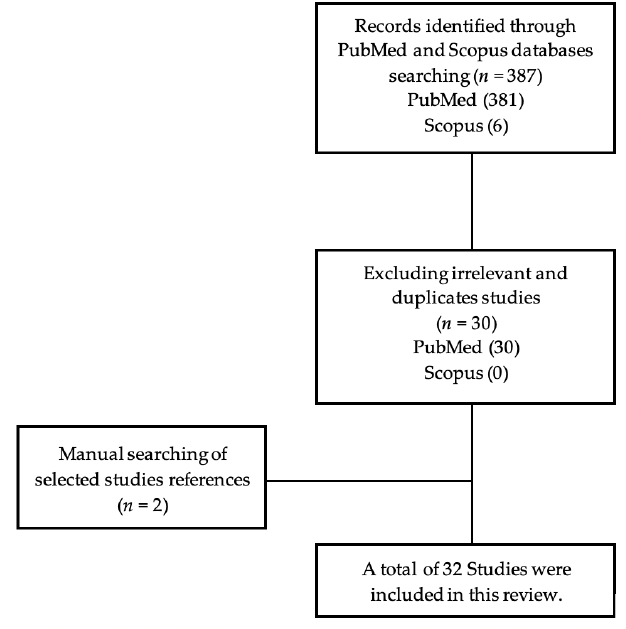
Figure 1. Flow chart of the studies selection.